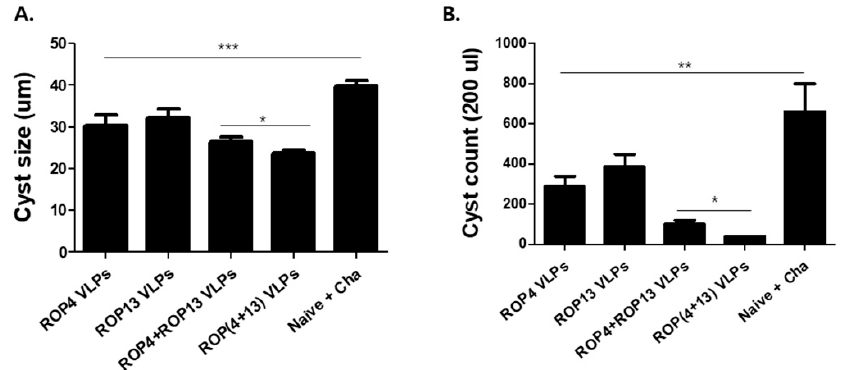
Figure 7. Cyst size and cyst count after T. gondii ME49 challenge. Thirty days after challenge infection with 450 T. gondii ME49 cyst, brain tissues were collected from mice ( n = 5). Cyst size (( A ), * p < 0.05, *** p < 0.001) and cyst count (( B ), * p < 0.05, ** p < 0.01) among VLPs immunization groups were compared. ROP(4 + 13) VLPs of cyst size (27.84um) was significantly reduced compared to naïve challenge (41.04um). Also, 40 cysts were counted from the brains of ROP(4 + 13) VLPs-immunized mice, whereas 660 cysts were counted from naïve challenge mice.